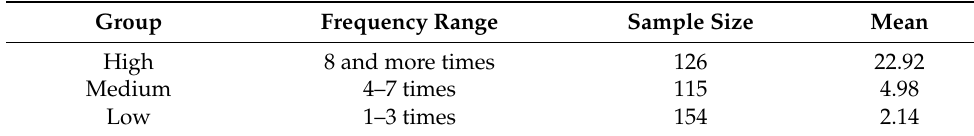
Table 1. Grouping three groups of international travel.